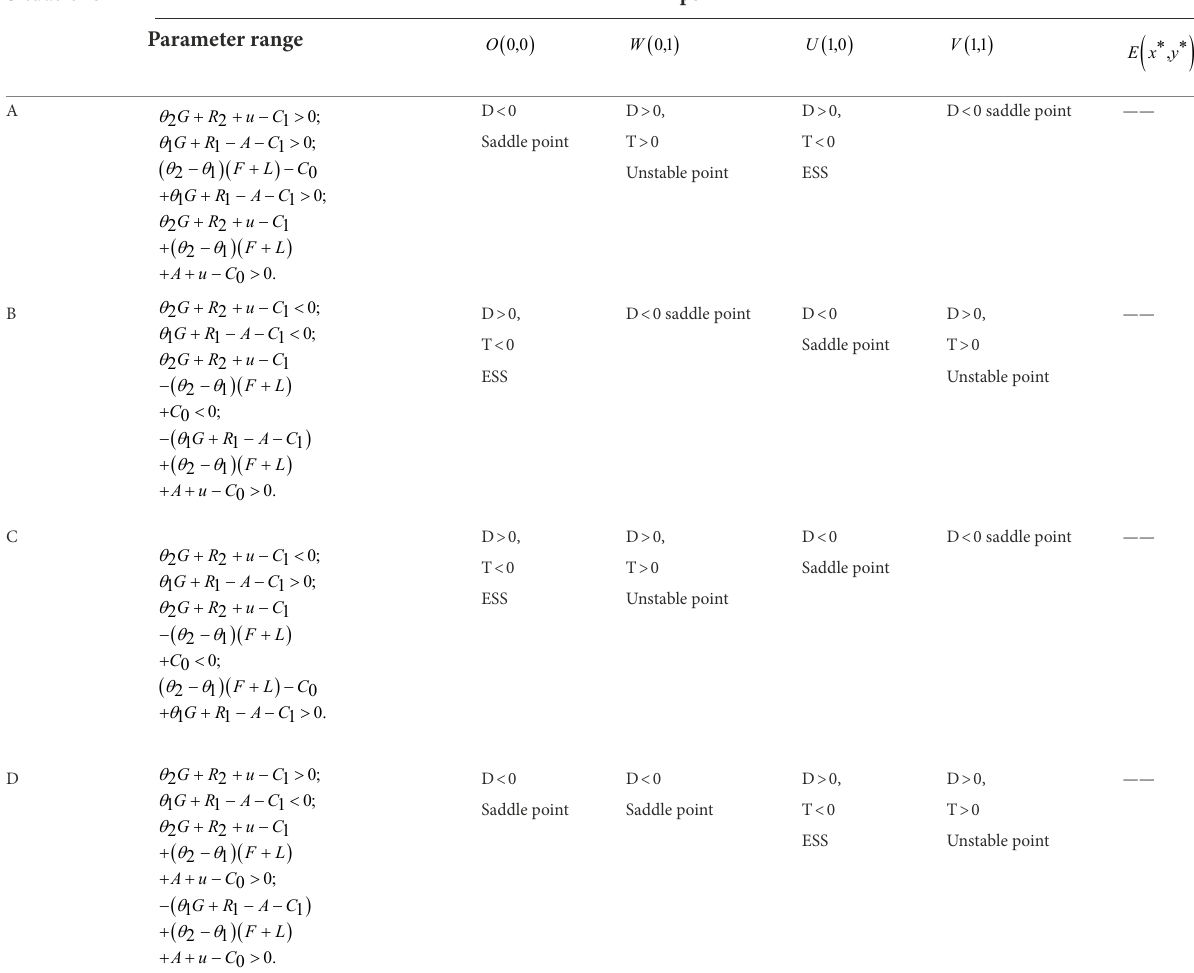
TABLE 3 Stability analysis of equilibrium points for (